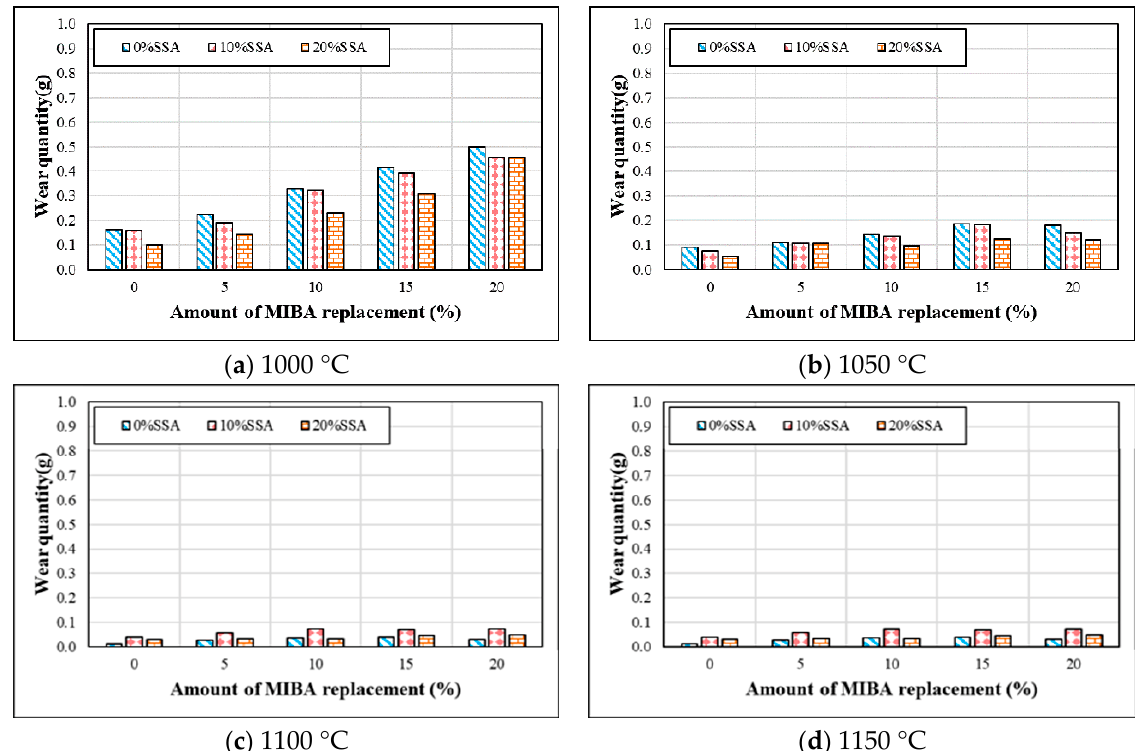
Figure 9. Wear resistance of specimens at different sintering temperature. ( a ) 1000 °C; ( b ) 1050 °C; ( c ) 1100 °C; ( d ) 1150 °C.